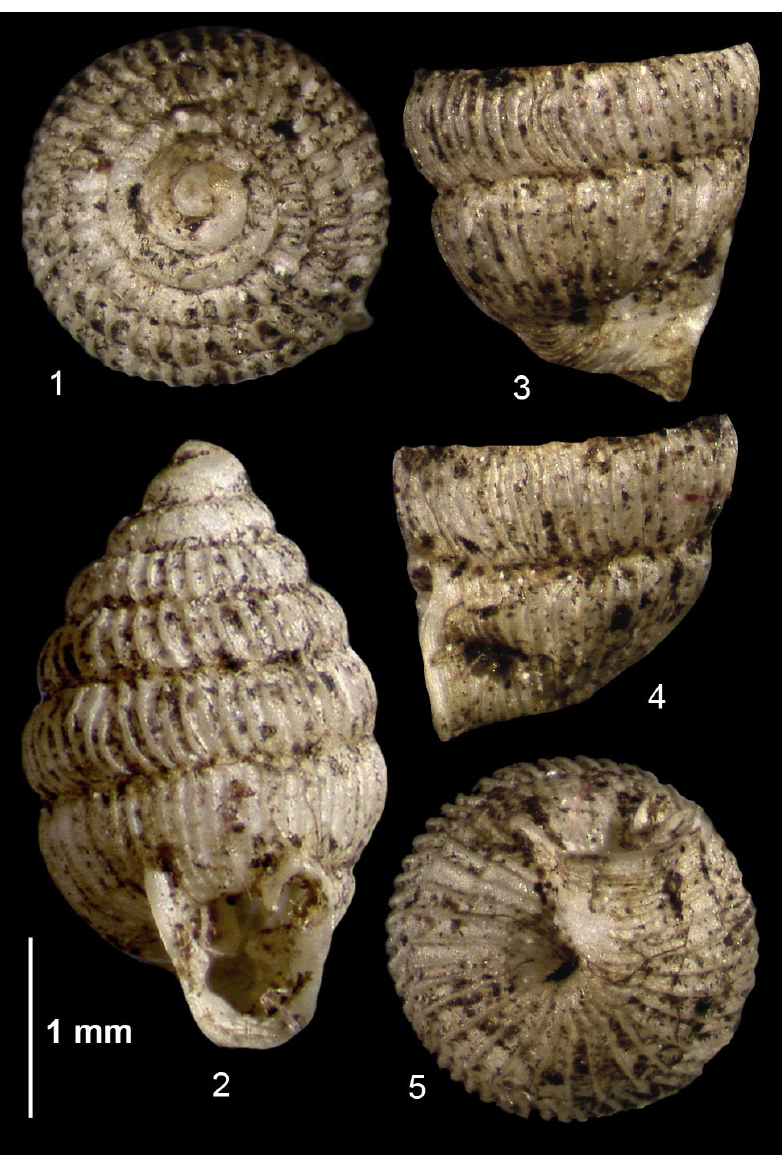
Figs 1-5. Lectotype of Ennea radius Preston, 1910, type species of Dadagulella gen. nov. 1. Apical view. 2. Apertural view. 3. Last two whorls, from left side. 4. Last two whorls, from right side. 5. Umbilical